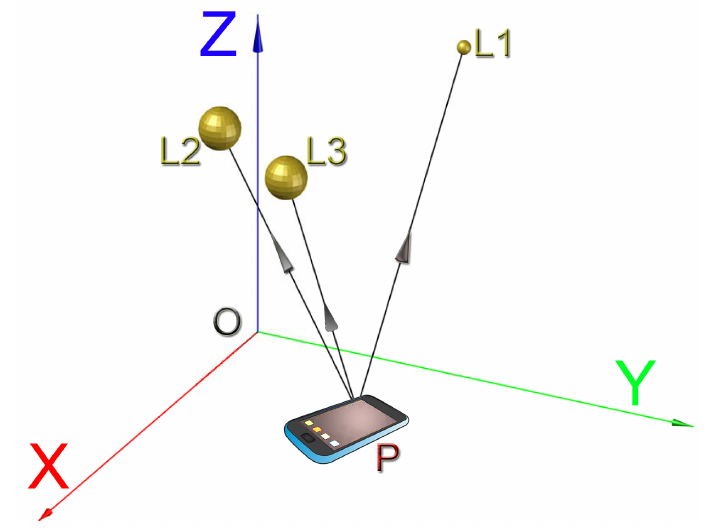
Figure 3. A scenario with a set of luminaires and a mobile